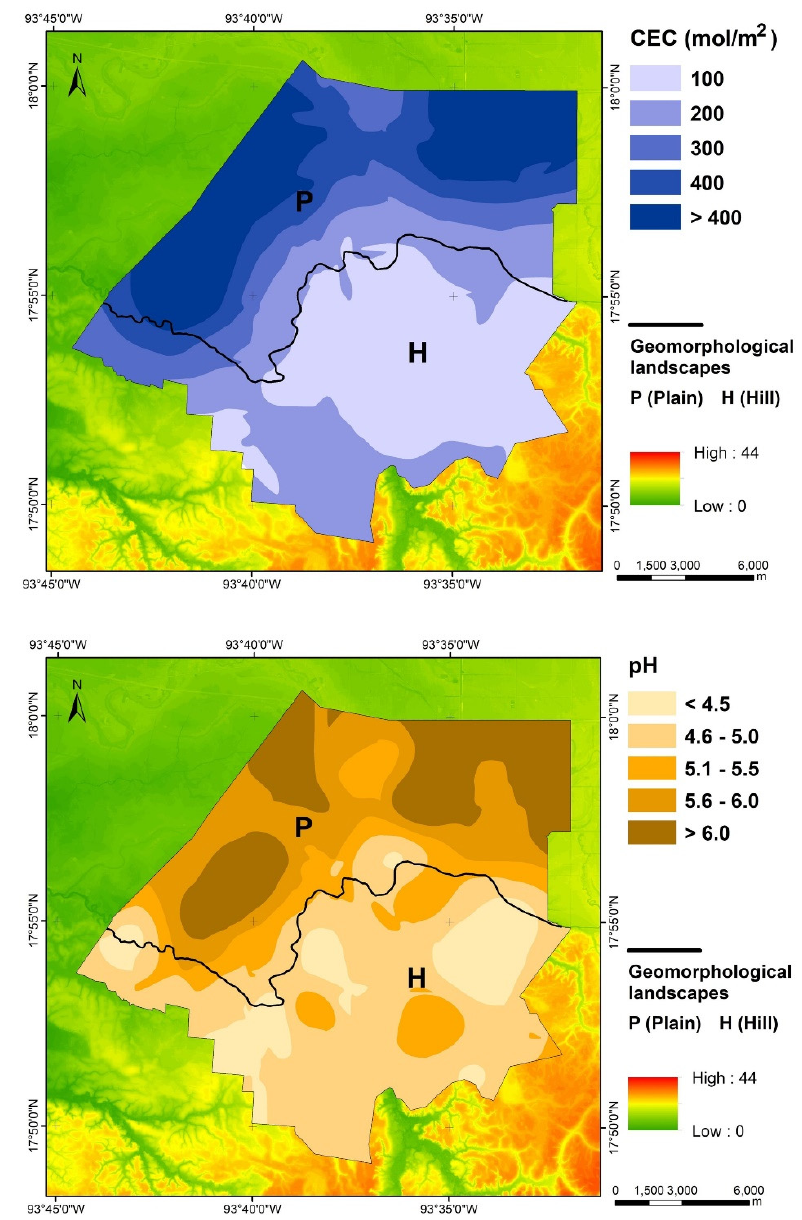
Figure 2. Spatial distribution of soil properties CEC and pH.